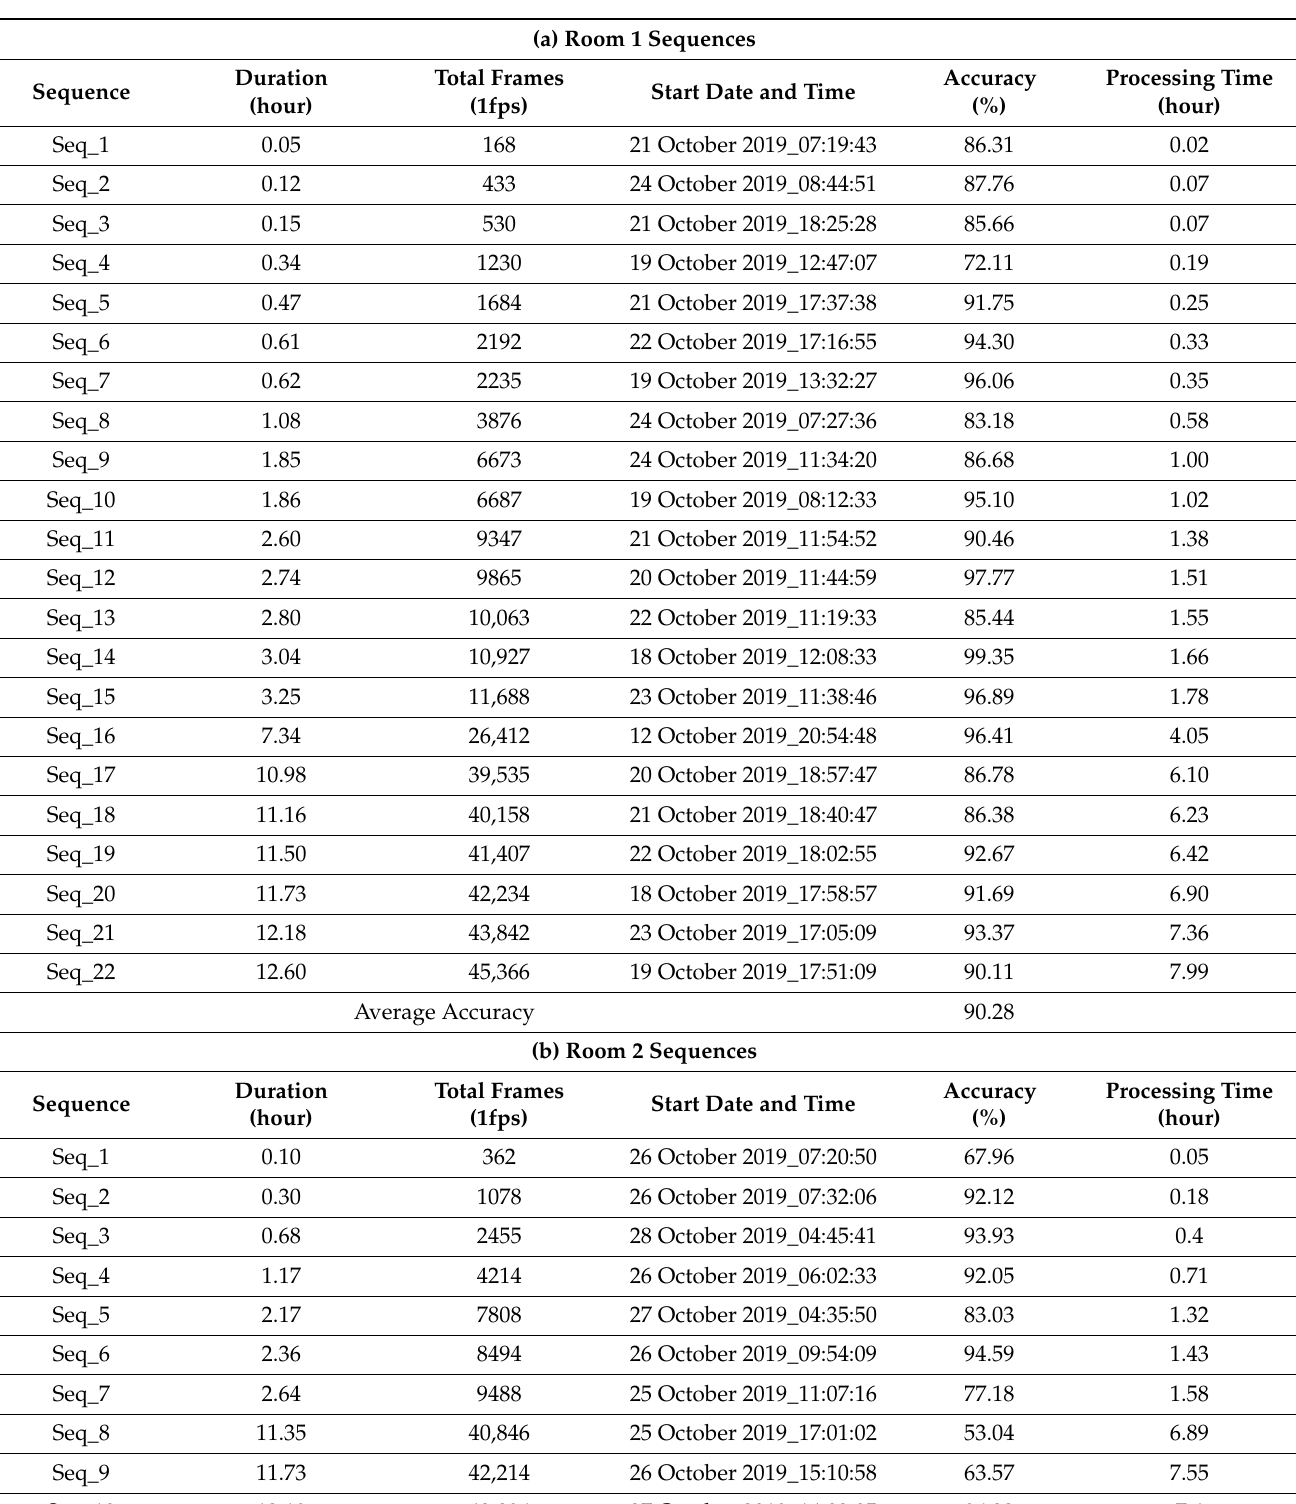
Table 7. Accuracy for each testing sequence from each room tested with the SVM + HMM method. (a) Room 1